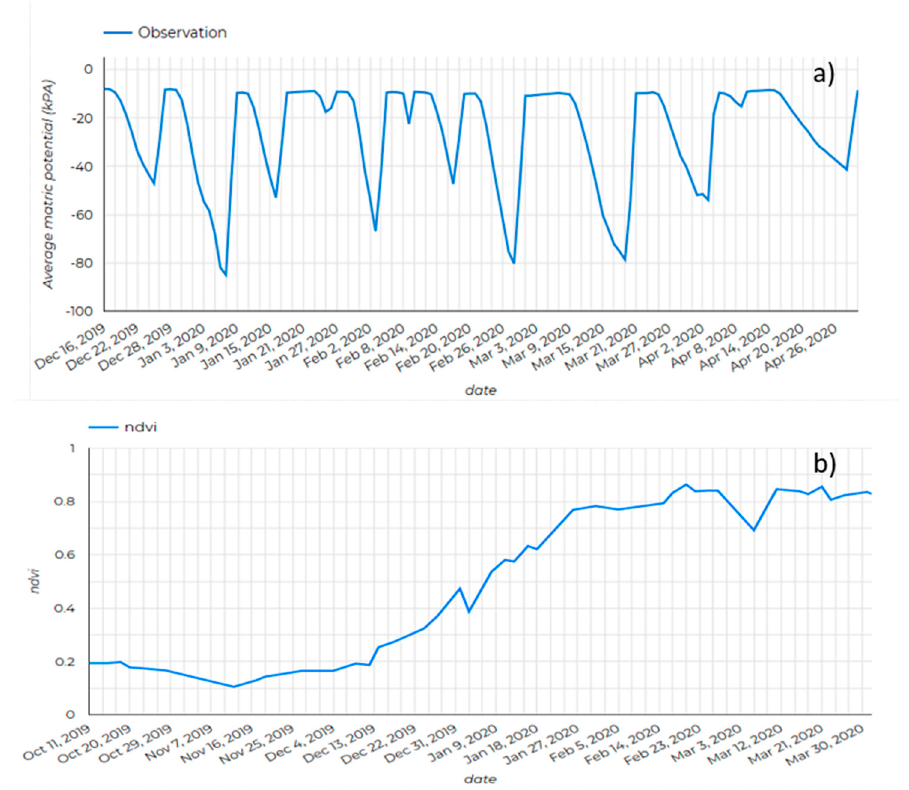
Figure 7. Soil matric potential ( a ) and the normalized difference vegetation index (NDVI) ( b ) monitored in one of the cotton farms over the crop season.